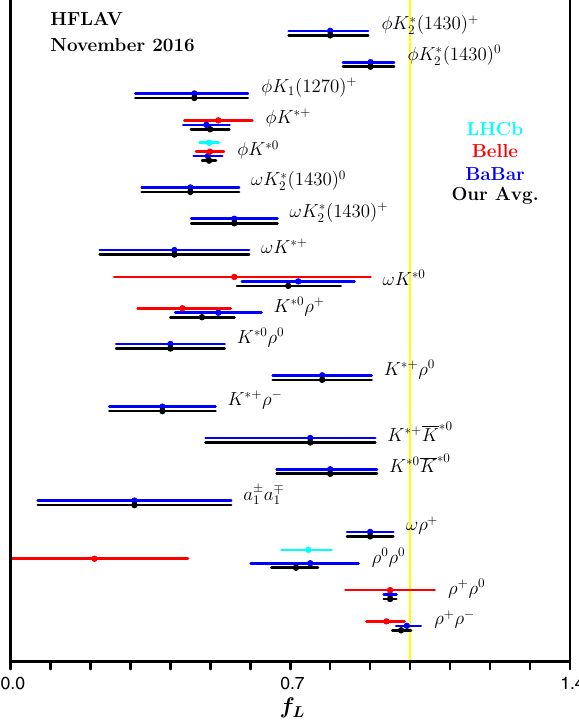
Fig. 189 Longitudinal polarization fraction in charmless B decays Table256 Results of the full angular analyses of B 0 s → K ∗ 0 K (blue), this indicates that they are new published (preliminary) results since PDG2014 Parameter PDG2014 Avg. Our Avg.